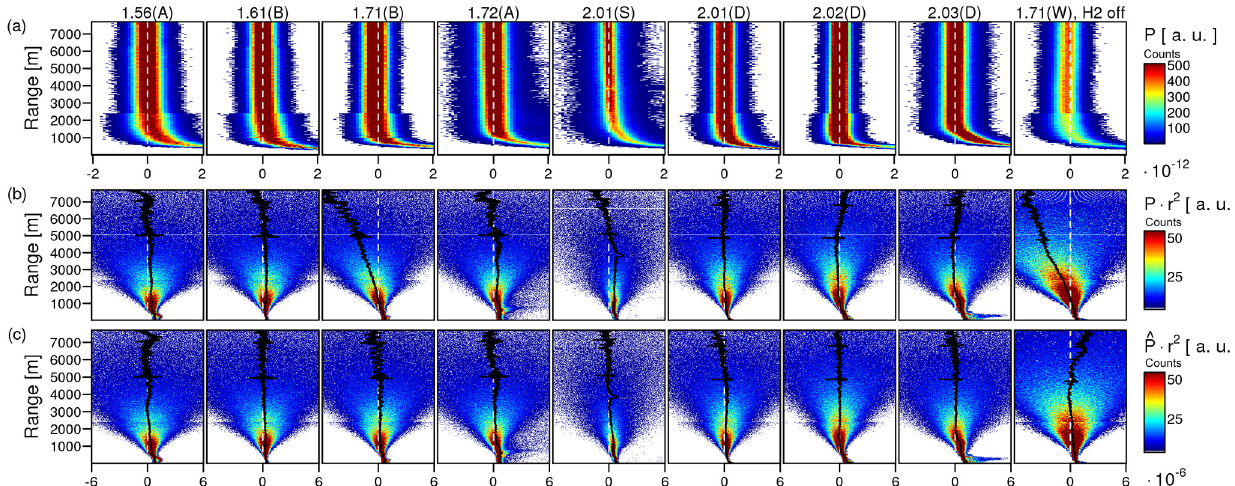
Figure 1. Range histograms for 24h of observations from Vaisala CL31 ceilometers operating with firmware versions (1.56–2.03) on different clear-sky days. Sensor ID in brackets (see Table 2 for settings, e.g. H2 = off for sensor W). Rows: range histograms in arbitrary units (a.u.) of (a) signal P , (b) range-corrected signal reported RCS = P · r 2 , and (c) range-corrected, background-corrected signal ˆ P · r 2 (Sect. 3.1). Median profiles (solid lines) are included in (b) and (c) . The H2 setting (Sect. 3.2) allows switching off of the range correction above 2400m for regions with no clouds